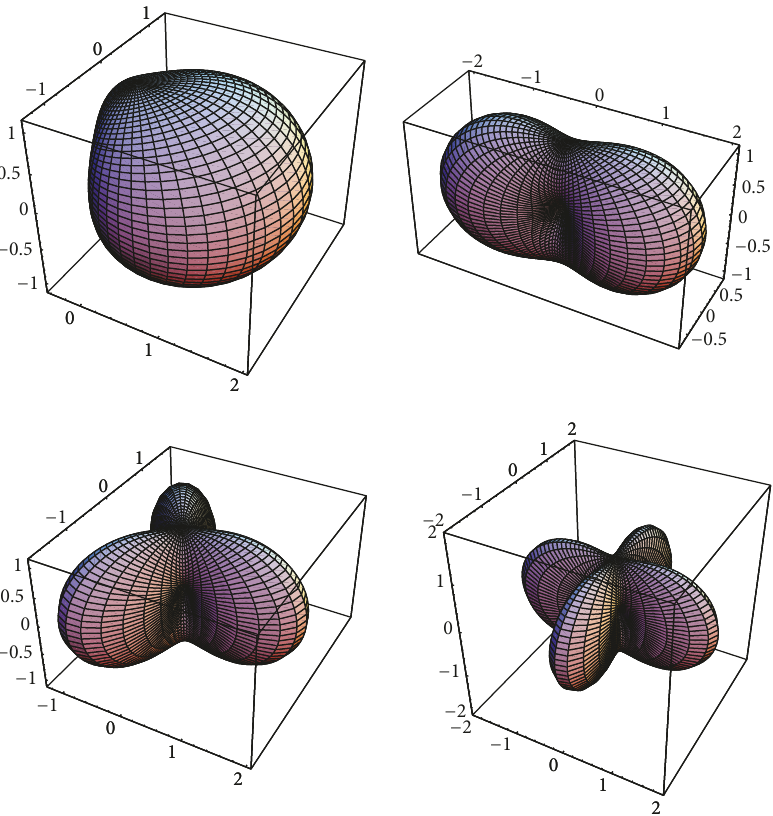
Figure 10: Isoplot surfaces |Ψ 𝑁𝐿 | = 0.9 for 𝐿 = 1, 2,3,4 from left upper frame, clockwise. We choose 𝑎 ∞ = 100, 𝜒 = 1,𝐿 1 = 0,𝑘 1 = 1 and the minimal energy was obtained for 𝑘 2 = 3